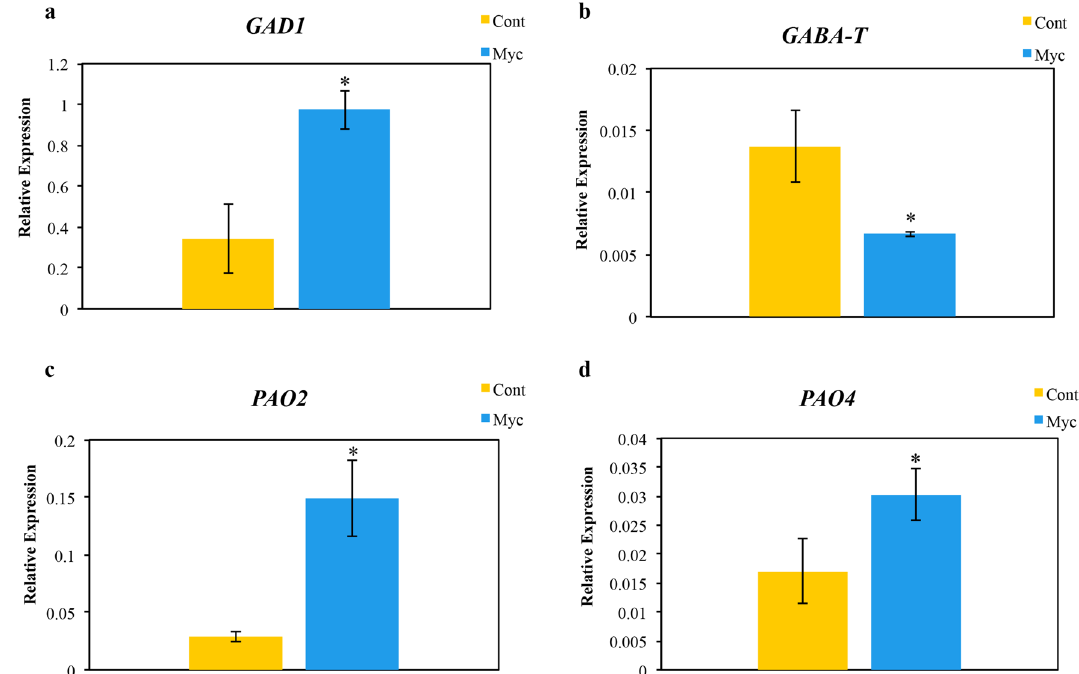
Figure 7. Genes expression profile of genes involved in GABA metabolism ( GAD1 , GABAT , PAO2 , PAO4 ) analysed by real-time PCR. Bars represent averages ± SD of 3 biological replicates of mycorrhizal (Myc) and non- inoculated (Cont) cork oak plants. *Indicate statistical differences at the level P < 0.05 (Mann–Whitney U